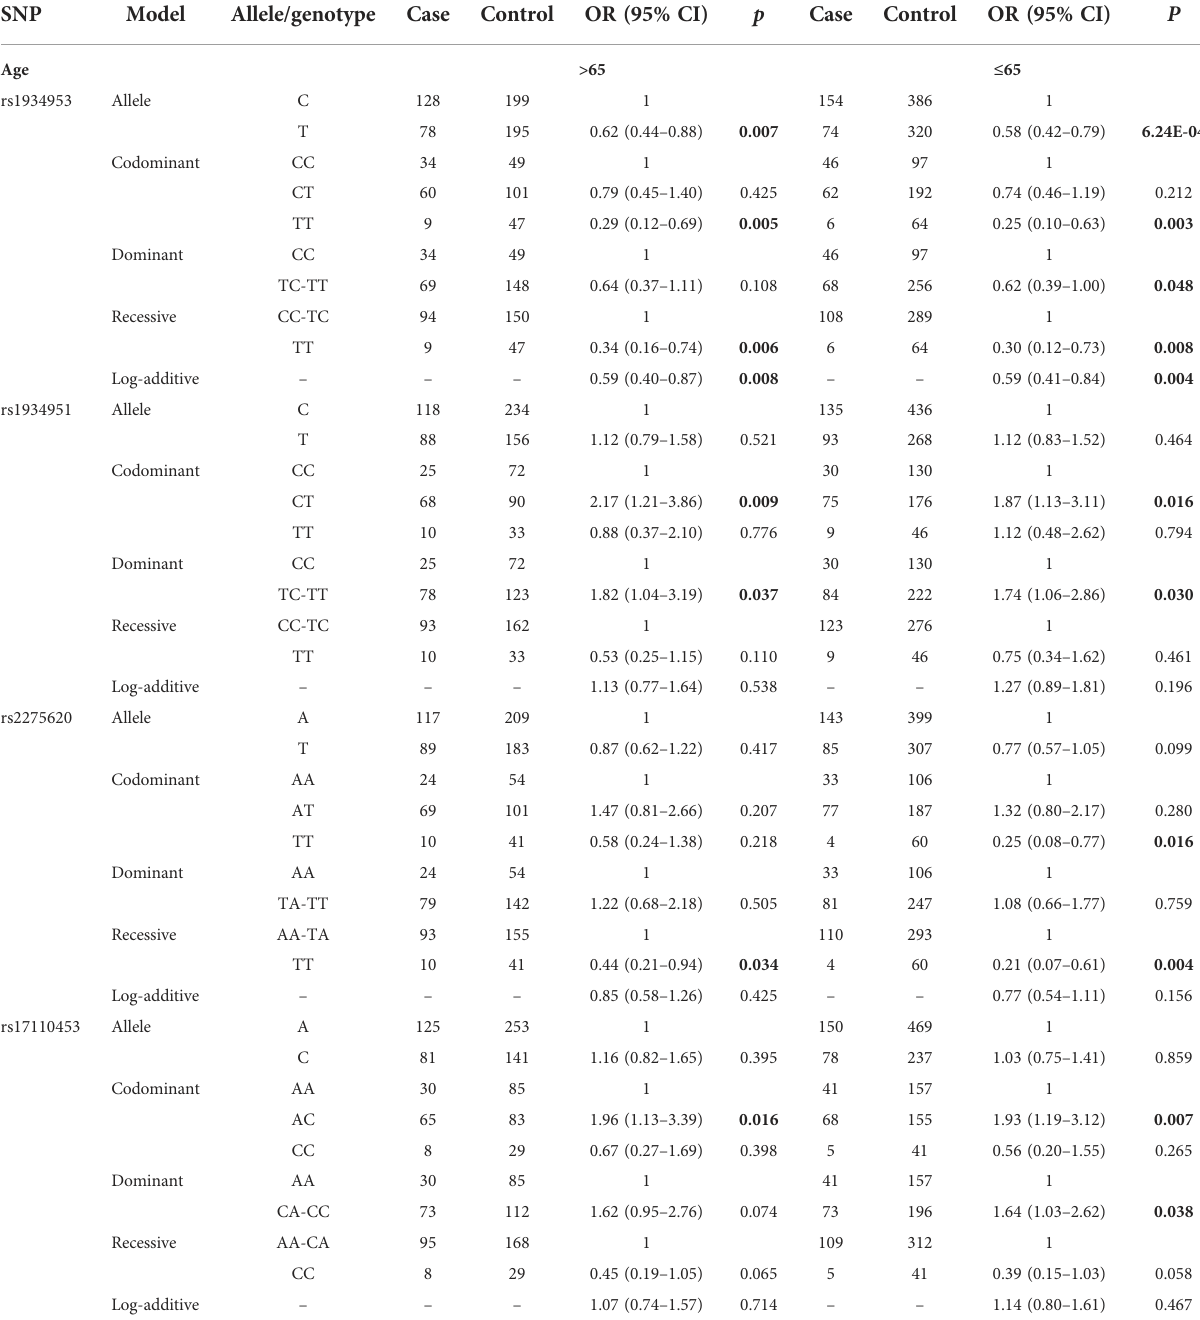
TABLE 5 Association of CYP2C8 SNPs with the risk of bladder cancer strati fi ed by